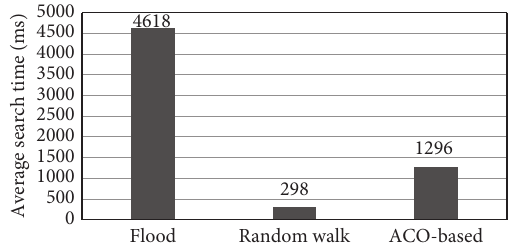
Fig. 2 Average search time contrast